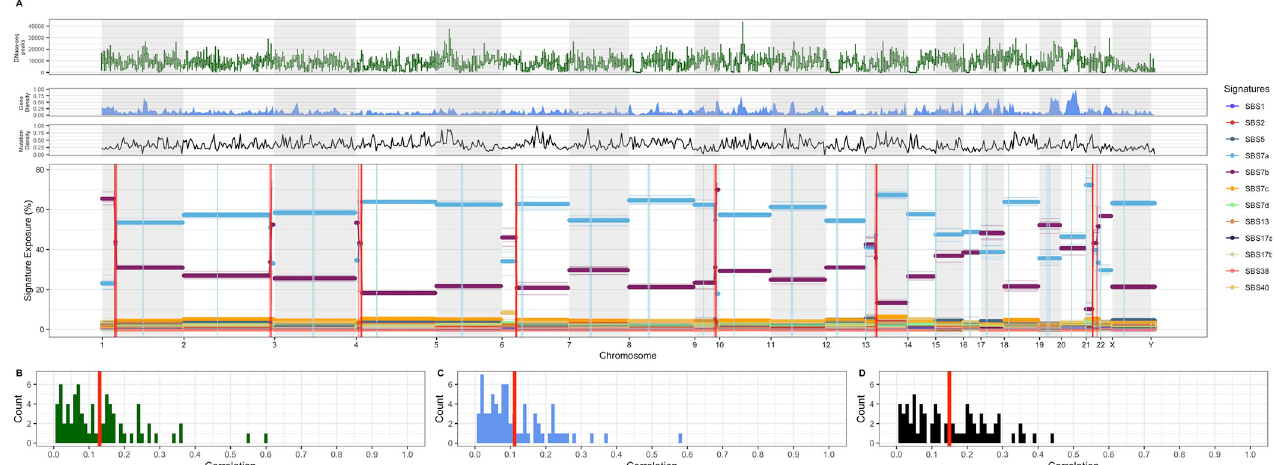
Fig 5. The association of signature activity profiles and chromatin accessibility, gene density, and mutation density profiles. A: Signature activity profile (chromosome-wise) for a representative melanoma sample with 168,604 mutations and 13 changepoints. Colored lines denote signature activities across bins of 200 mutations. Alternating gray and white bars denote chromosomal boundaries, and vertical blue lines show centromere positions. Red vertical lines show changepoint locations, and the opacity of these lines denotes confidence in that changepoint’s location. Above, black line plot depicts mutation density at each bin across the genome. Mutation density is normalized such that the bin with the highest density throughout the genome is scaled to one and the bin with the minimum density is scaled to zero. Above, the blue area plot represents the average gene density at each bin, as determined from gene counts in hg19 [35]. Gene density is normalized in the same manner as mutation density. Above, the green line plot depicts chromatin accessibility throughout a primary melanocyte genome as determined via DNAse-I accessibility index [33]. Horizontal lines at each bin show the average chromatin accessibility across each bin, and vertical lines depict the range of chromatin accessibility values within each bin. B, C, and D show the distribution of correlation values between changepoint locations and DNAse-I accessibility index, gene density, and mutation density, respectively, across the 74 melanoma samples which contain changepoints. Mean correlation is highlighted in red on each